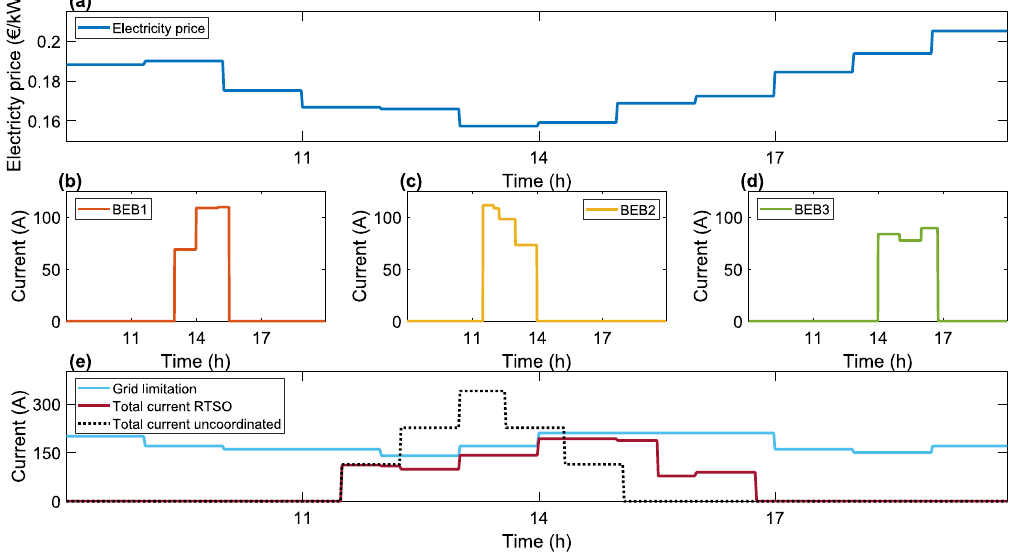
Figure 6. Simulation results of three BEBs charging during the day with ( a ) electricity tariff, ( b – d ) charging current of each BEB and ( e ) total charging current and grid limitation.